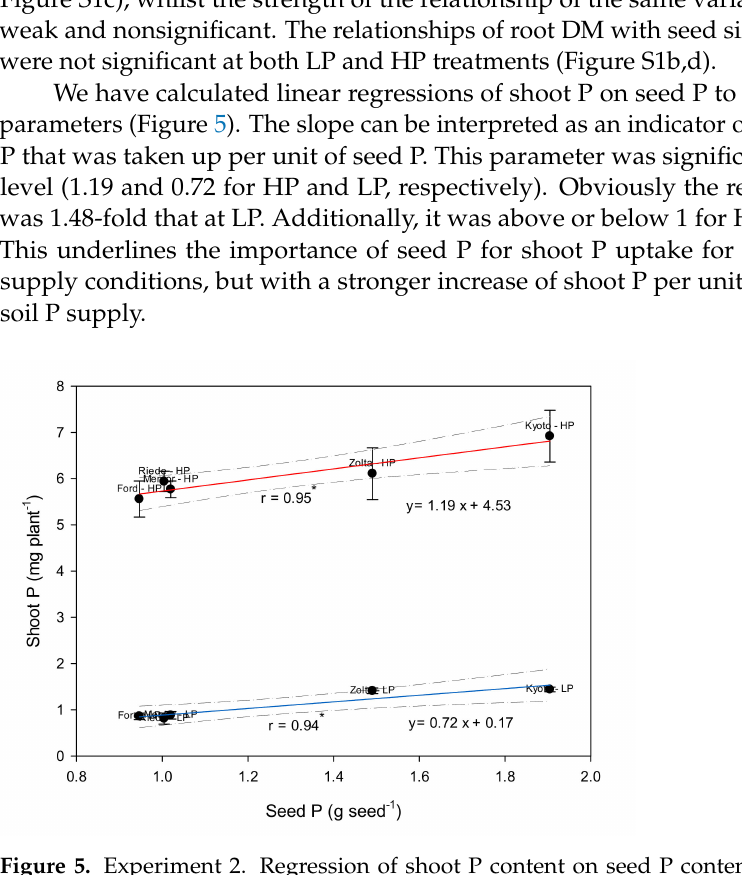
Figure 5. Experiment 2. Regression of shoot P content on seed P content. Error bars represent standard errors ( n =